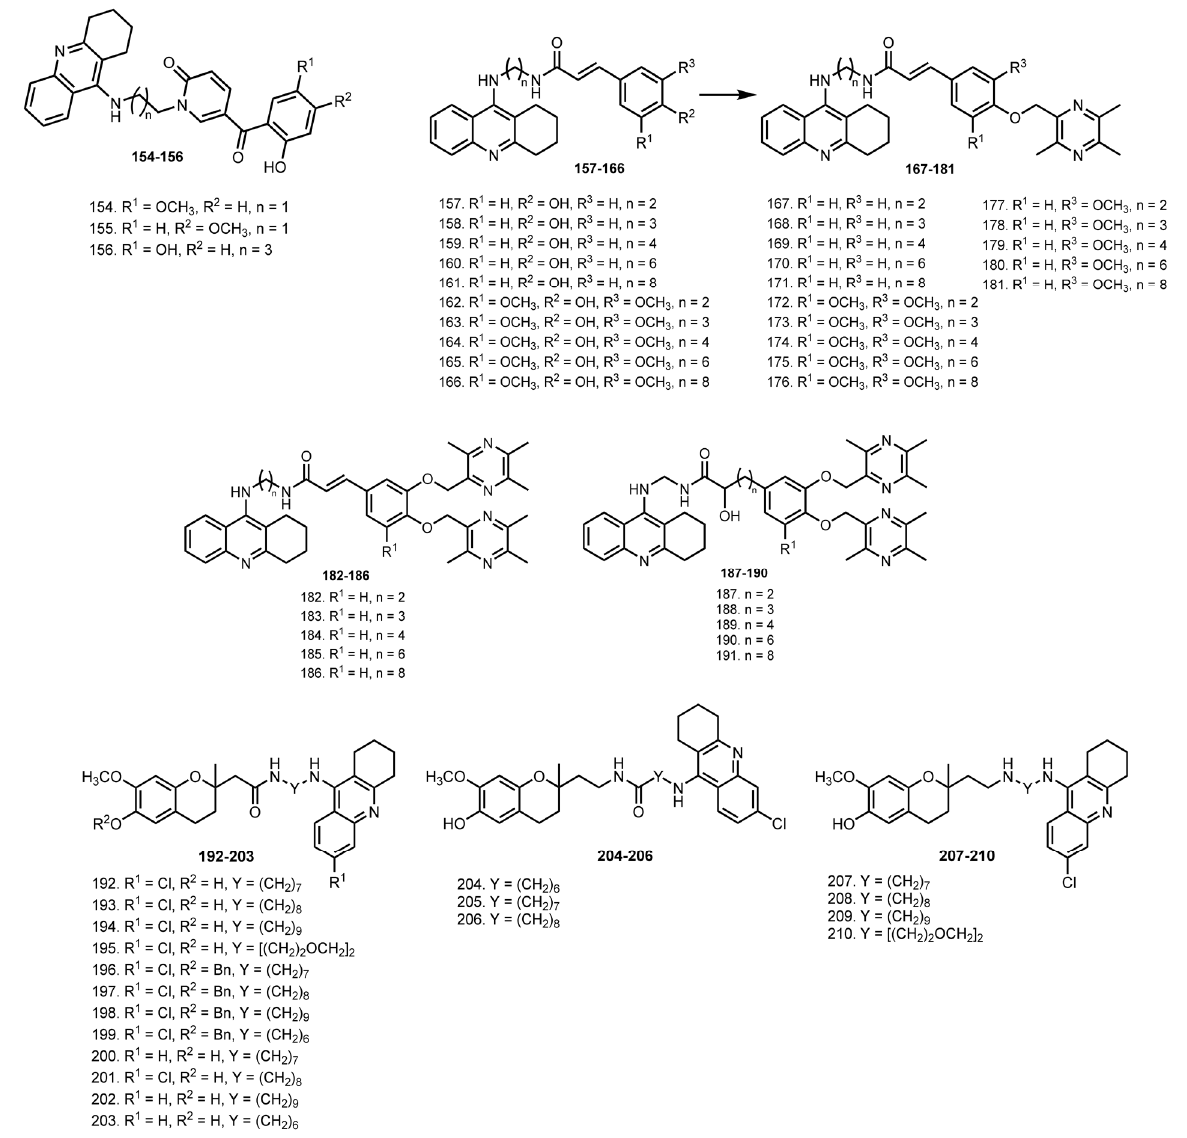
Figure 7. THA–(hydroxybenzoyl ‐ pyridone) hybrids 154 – 156 [53], THA–phenolic acid